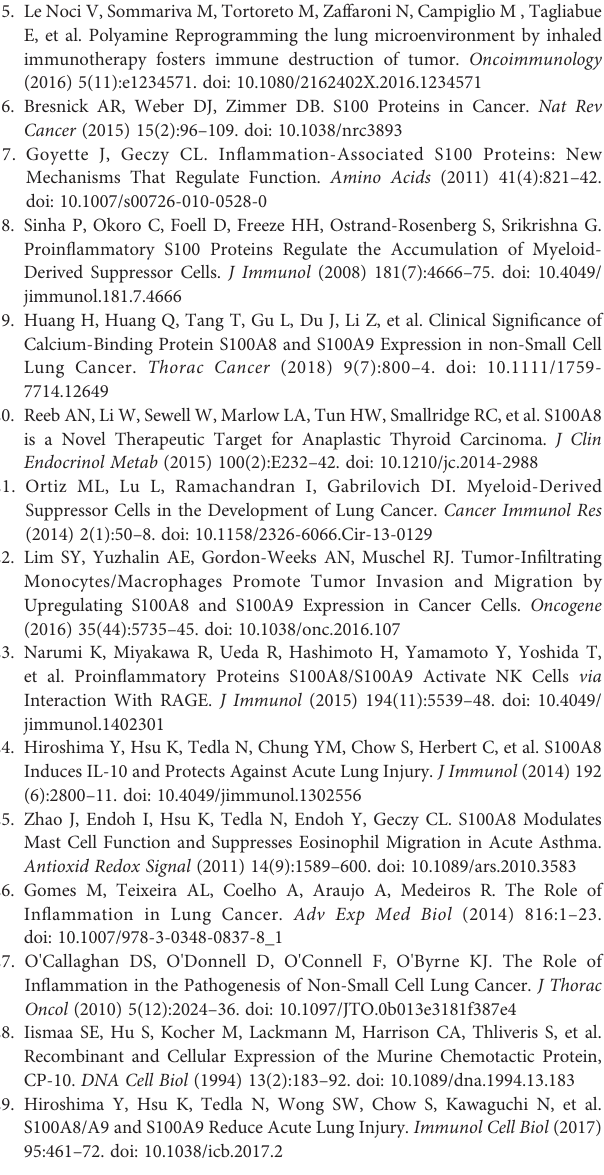
Supplementary Table1 | Expressionpro fi lesof98genesin lungsofmice treated with or without S100A8 in the presence/absence of orthotopic LLC tumors. Supplementary Table 2 | Total percentage of myeloid-derived suppressor cell (MDSC) populations in lungs, spleen, bone marrow and lymph nodes of mice treated with or without S100A8 in the presence/absence of orthotopic LLC tumors. Supplementary Table 3 | Total percentage and absolute numbers of lymphocyte populations in lungs and spleen of mice treated with or without S100A8 in the presence/absence of orthotopic LLC